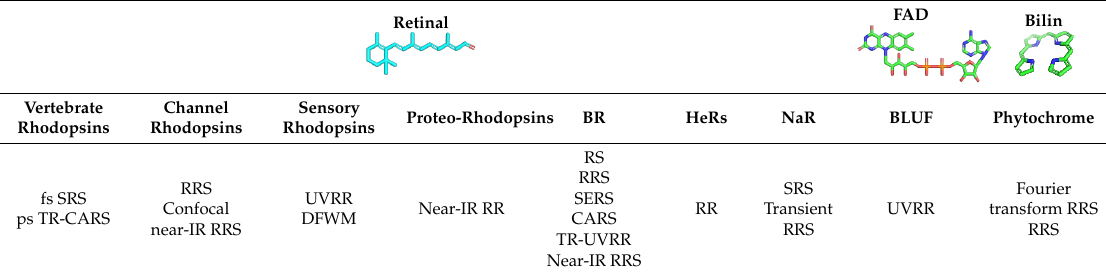
Table 1. RS relevant techniques applied to the most studied classes of photoactive proteins. Retinal